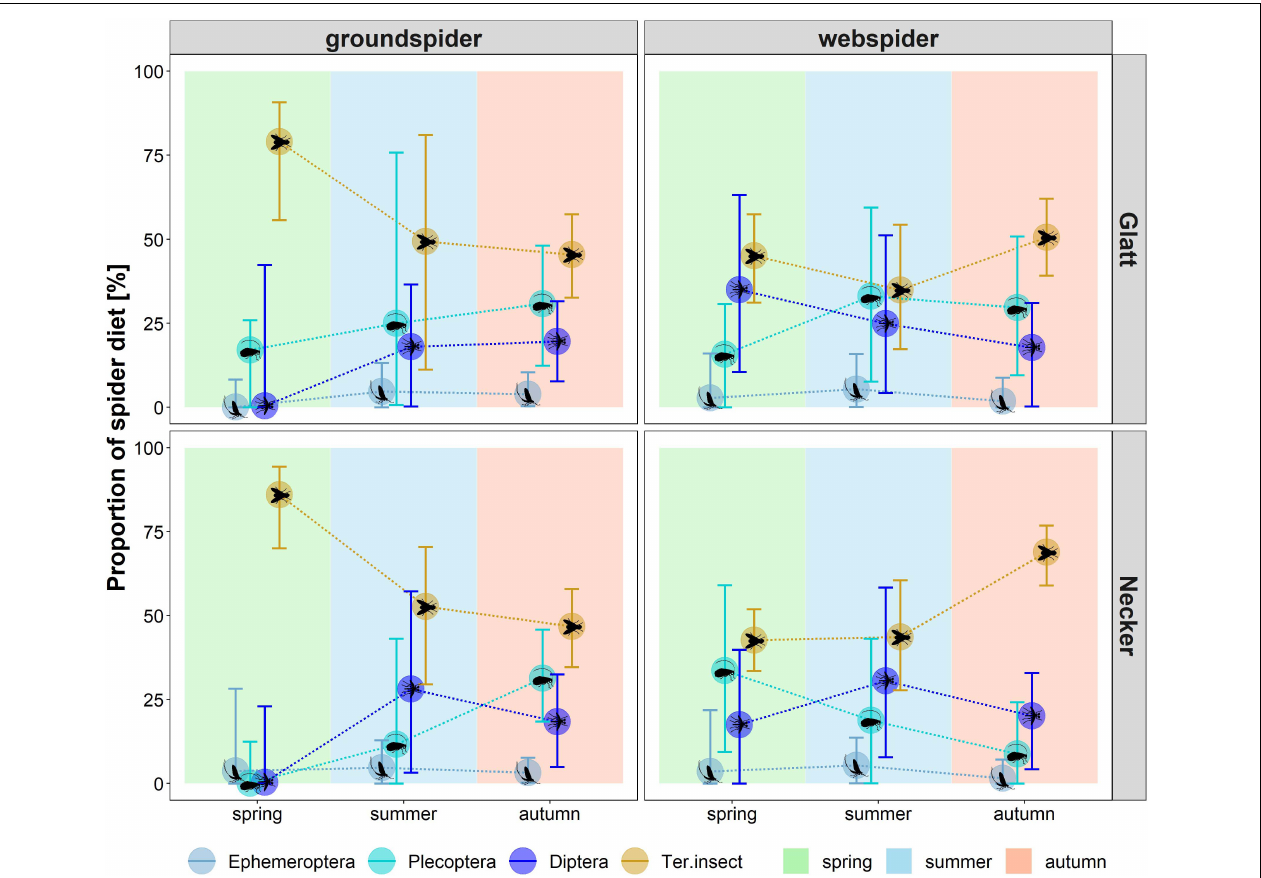
FIGURE 8 | Estimated dietary contribution of aquatic and terrestrial food sources derived from MixSIAR multi-source Bayesian model to diet of web spiders and ground spiders in spring, summer and autumn at the two different rivers. Dietary tracers included δ 13 C, LIN, ALA, SDA, ARA and EPA for web spiders and δ 13 C, LIN, ALA, SDA and EPA for ground spiders. Models were calculated separately for each season and spider type. Results are presented as median and 95% credibility